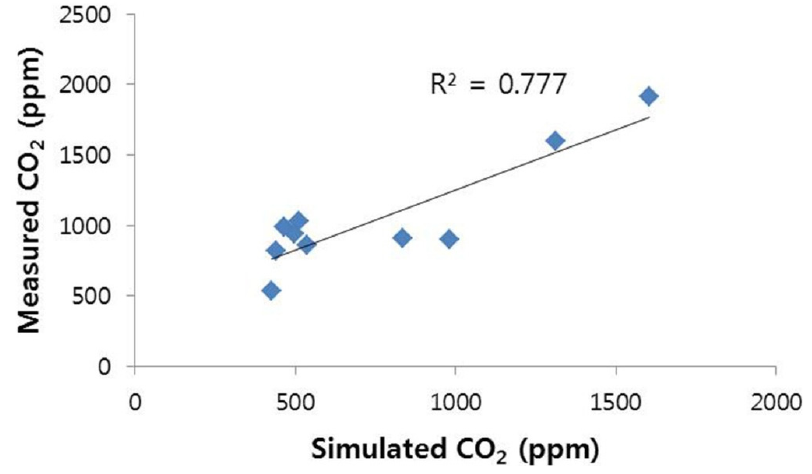
Figure 10. Correlation of simulated CO 2 and measured CO 2 .